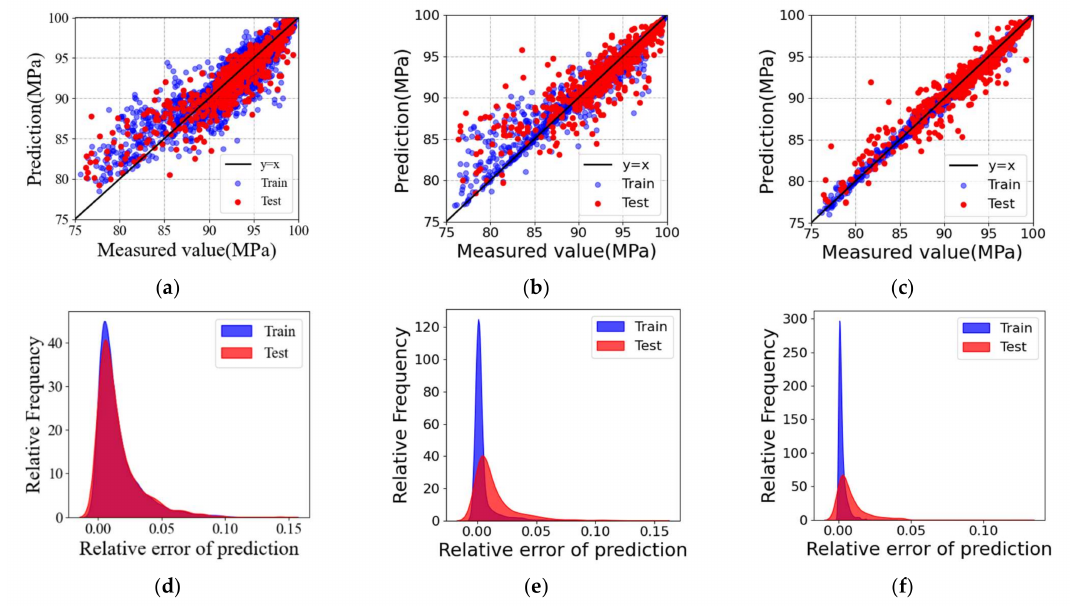
Figure 5. Regression analysis on the training dataset and the unseen test dataset by the trained ML models using a small dataset. The experimental measurements and the numerical predictions predicted by ( a ) DNN, ( b ) SVR, and ( c ) the present model. Distribution plot of relative error for the training dataset and the unseen test dataset evaluated in ( d ) DNN, ( e ) SVR, and ( f ) the present optimized XGBoost